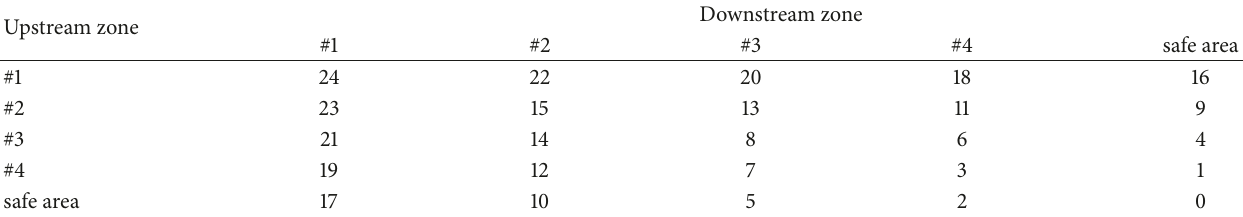
Table 4: Road risk level according to improved method.